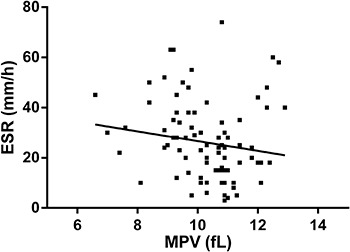
Correlation between mean platelet volume (MPV) and erythrocyte sedimentation
rate (ESR) in patients with polymyositis (PM).